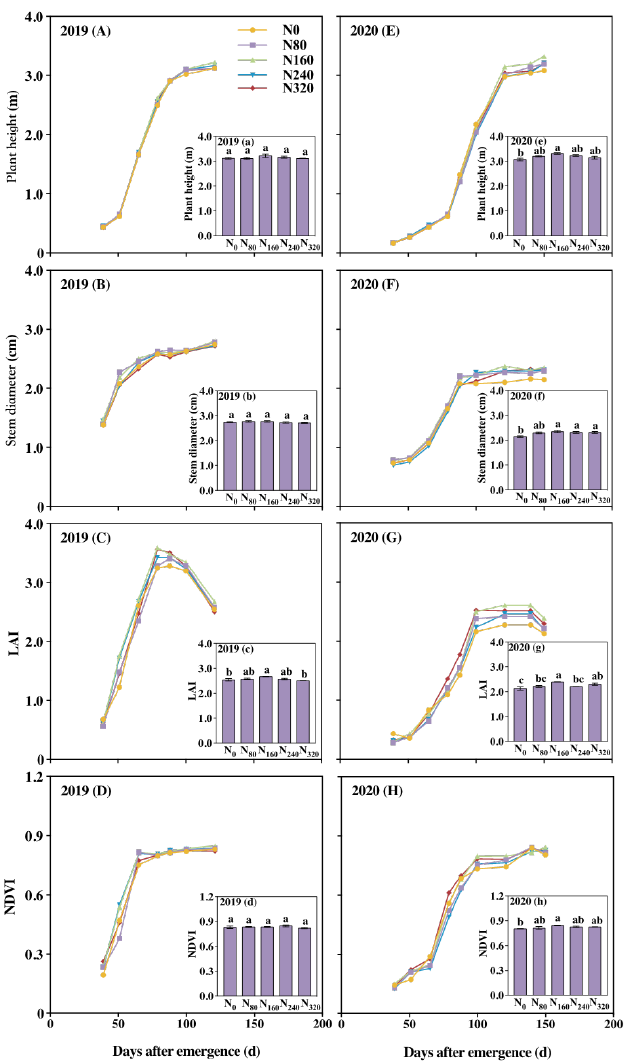
Figure 2. Dynamics of mean plant height ( A , E ), stem diameter ( B , F ), LAI ( C , G ), and NDVI ( D , H ) of forage sorghum and their mean values at the harvest stage under different N application rates in 2019 and 2020 ( a – h ). Different lowercase letters indicate significant differences at p < 0.05 among the different N treatments.